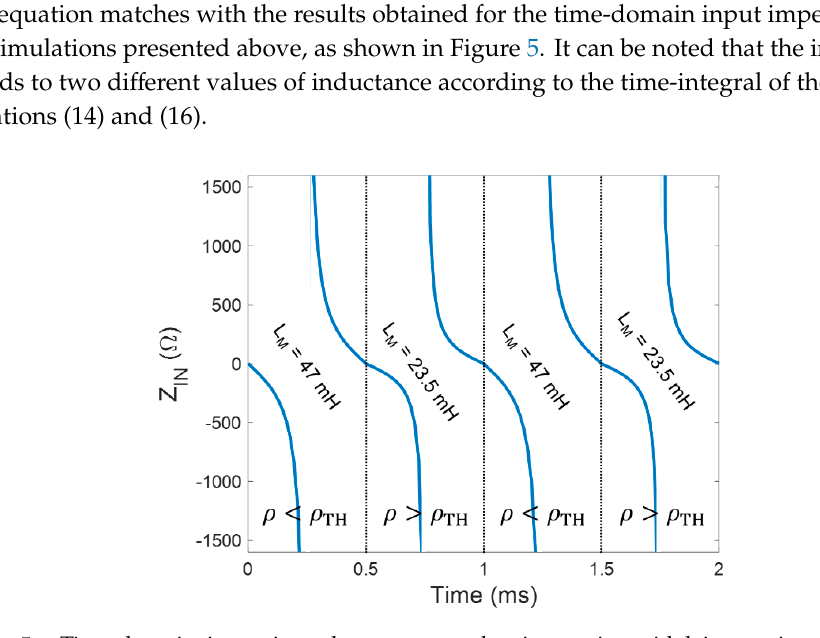
Figure 5. Time-domain input impedance extracted using a sinusoidal input signal under the configuration presented in Figure 3.